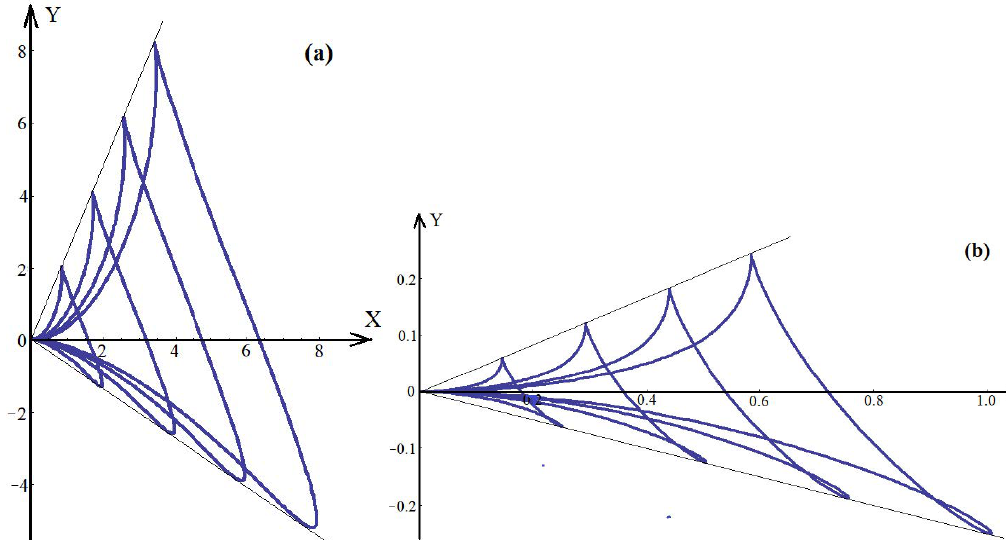
Figure 8. The lines of the constant phase θ ( X , Y ) = const for different values of shear current: ( a ) positive shear components ( W X = W Y = 1/ 2); ( b ) Opposite ( W X = − W Y = − 1/ 2) shear current components. A further increase in shear flow leads to a negative direction of and arm angles o 68 . The directions of cusp waves 0 m m k k depending on the ray angle are ship waves / tan( ) Y X shown in Figure 9 for positive and negative X -components of shear W W W . A sketch of the phase lines for the flow , 1/ 2 X Y Y W W are presented in shear currents components 0.82, 0.82 Y X Figure 10a,b. The upper limit value of the positive shear flow 0.92 corresponds to the arm angle o 90 and zero- X m